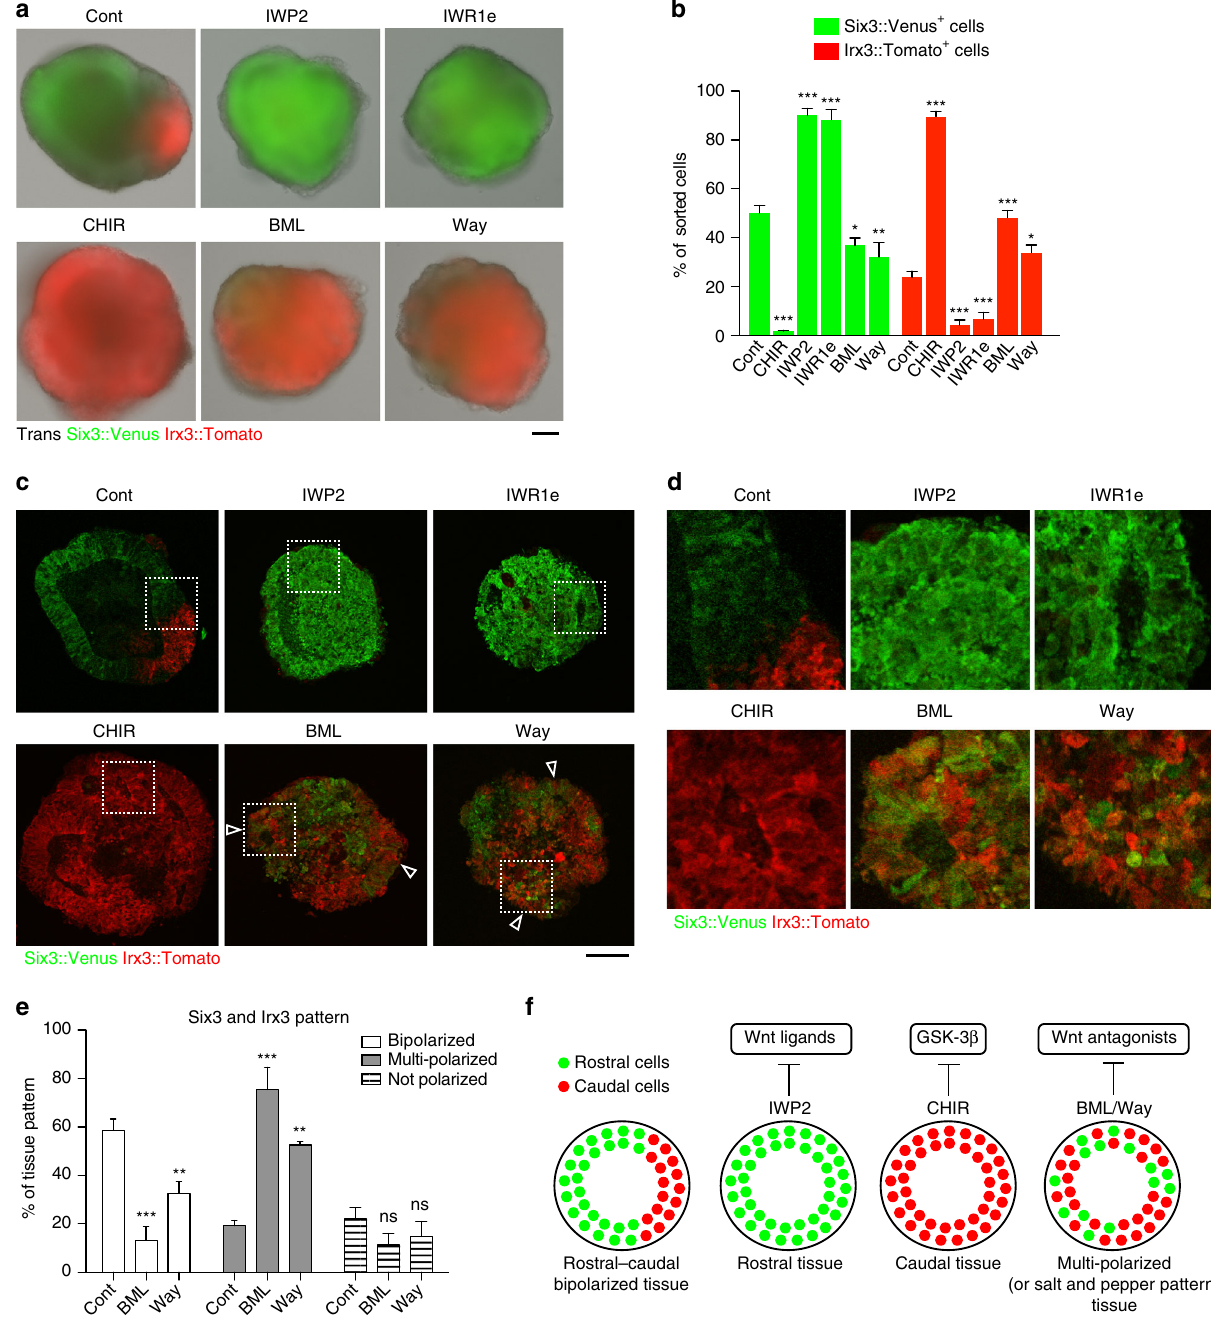
Fig. 6 Wnt signaling antagonism has a crucial role for rostral-caural neuroectoderm bipolarization. a Merged image of day-7 aggregates, showing Trans (transillumination), Six3::Venus and Irx3::Tomato. Pharmacological inhibition was performed from day 4 to 7. Cont, Control; CHIR, CHIR99021; IWR1e, IWR-1-endo; BML, BML-287; Way, Way-262611. b Quanti fi cation of Six3::Venus + and Irx3::Tomato + cells via FACS. c Merged image of cryosectioned day-7 aggregates, showing the expression of Six3::Venus and Irx3::Tomato. Open white triangles indicate multi-polarized (or salt and pepper pattern) portions. d High-magni fi cation images show the portion of broken-lined squares in c . e Quanti fi cation of the percentage of bipolarized and multi-polarized (including salt and pepper) patterns in Six3 and Irx3 expression. Cont ( N = 53); BML ( N = 44); Way ( N = 36). f A diagram comparing the effect of inhibition of Wnt components on rostral-caudal patterning. Multi-polarization includes salt and pepper pattern. Error bars indicate s.e.m of each experiment. Signi fi cance was determined using Dunnett test ( b , e ). * P < 0.05; ** P < 0.01; *** P < 0.001; ns, not signi fi cant. Cont, Control. Scale bars, 100 µ m ( a , c ). These images were one of n = 3 experiments ( a , c To test whether Wnt signaling components are expressed as Fig. 5D, E). Interestingly, fi ve soluble Wnt components — wnt1, a gradient along the NE, we fractionated day-6 cells into four wnt4, wnt8b, dickkopf1 ( dkk1 ), Secreted frizzled related protein 1 groups according to the level of Rax::GFP intensity (Fig. 5c, d). ( sfrp1 ) — and the target gene, axin2 , exhibited expression in The levels of six3 and irx3 expression became gradually higher a gradient (Fig. 5e). Speci fi cally, wnt1 expression became − and lower in the GFP + fractions, respectively (Supplementary gradually higher in the GFP fractions (corresponding to the